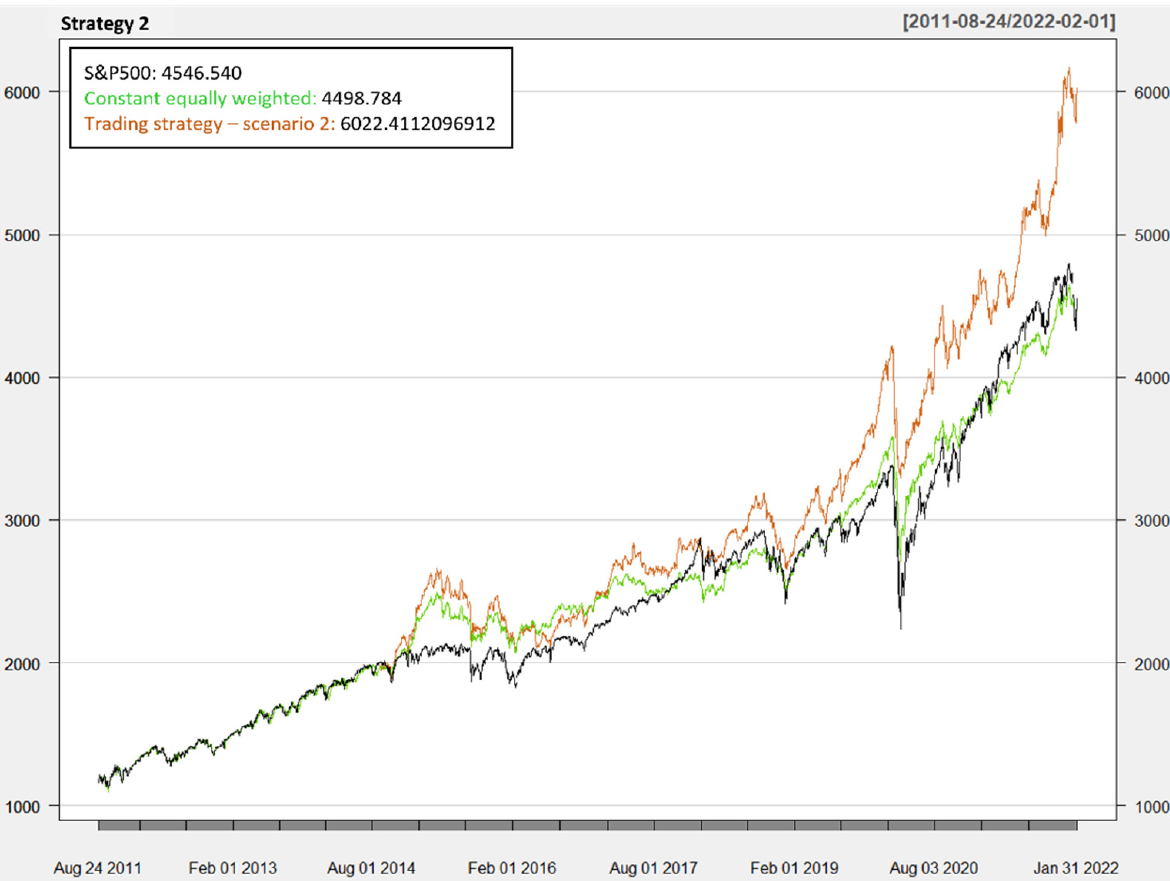
Figure 5 . The development of the wealth process of the S&P500 (black), Strategy 2 (orange), and a constant equally weighted portfolio (green) .